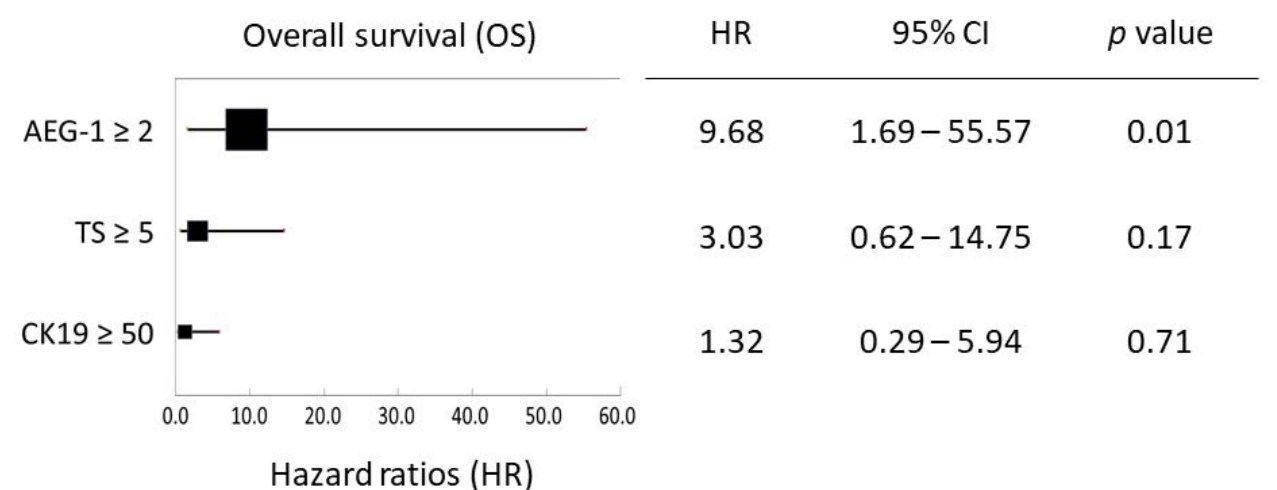
Figure 5. Cox regression multivariate analysis associated with overall survival (OS). AEG1: astrocyte-elevated gene-1; TS: thymidylate